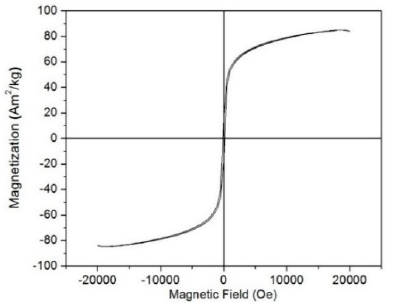
Figure 4. Hysteresis curve of manganese ferrite sample at room temperature.